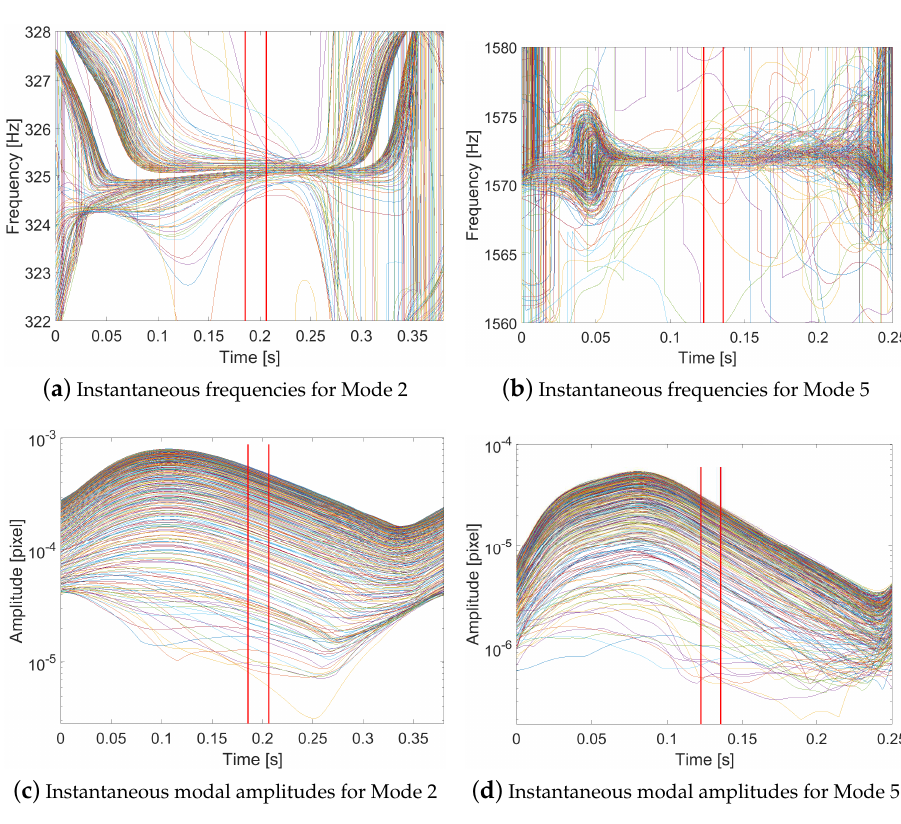
Figure 8. Instantaneous frequencies and modal amplitudes (in log scale) obtained from 300 measure- ment points of the neutral axis of a clamped–clamped beam for Mode 2 and